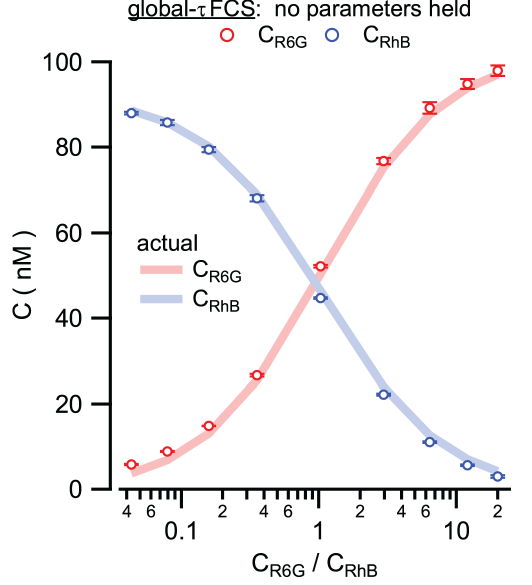
Figure 2. Comparison of Global- t FCS analysis with known R6G and RhB sample mixtures. Recovery of molecular concentrations across nine known concentration ratios using Global- t FCS. Calibrated known concentrations (solid lines) compared to recovered concentra- tions of R6G (red circles) and RhB (blue circles). Data points and error bars represent the average and standard deviation of three repeated experiments.